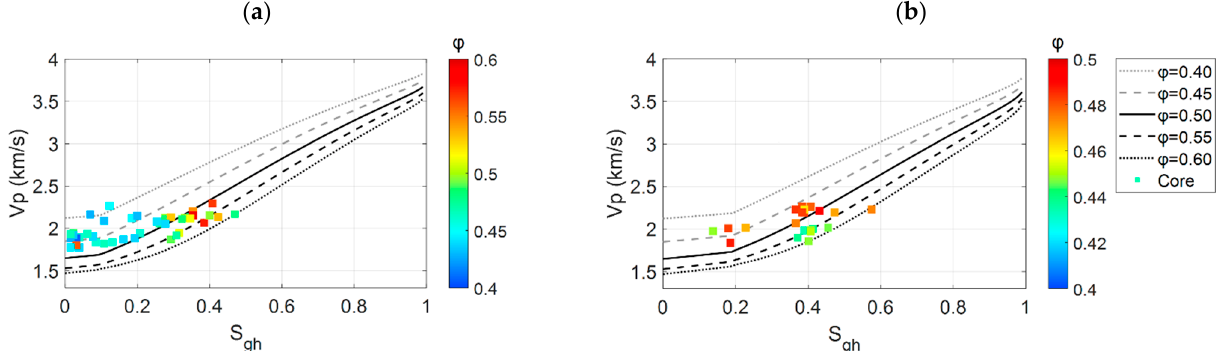
Figure 10. Modeled V P in terms of S gh for various values of φ for: ( a ) SH2 well, ( b ) SH17 well (note: S gh data in Figure 9b and c are color-coded by φ and overlaid in the plots with colorful dots).